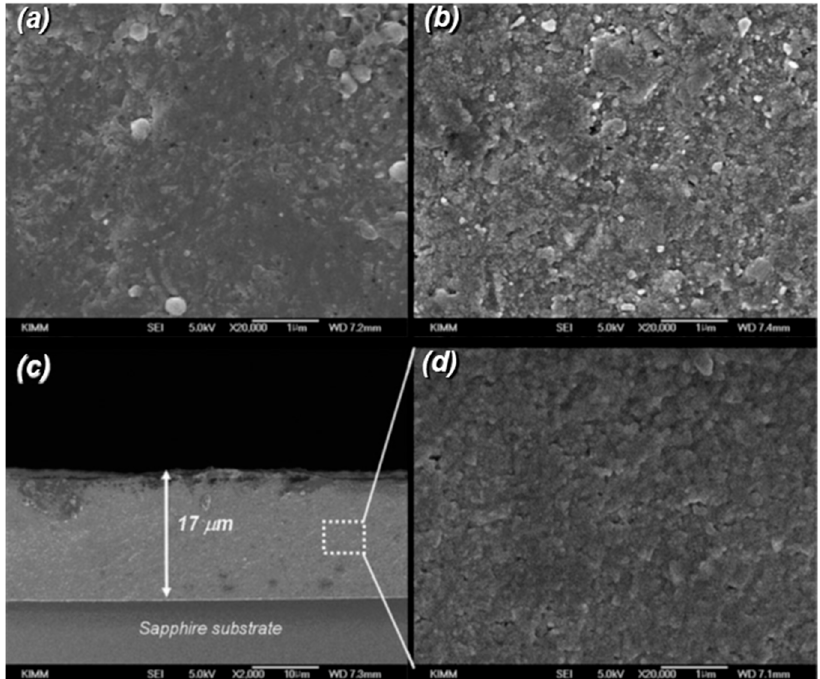
Figure 15. SEM images of the ( a ) as-deposited and ( b ) 800 °C-annealed KNN–LiSbO 3 (LSO) films. ( c ) Low- and ( d ) high-magnification cross-sectional views of the annealed film [33]. © Copyright 2008, Appl. Phys. Lett.